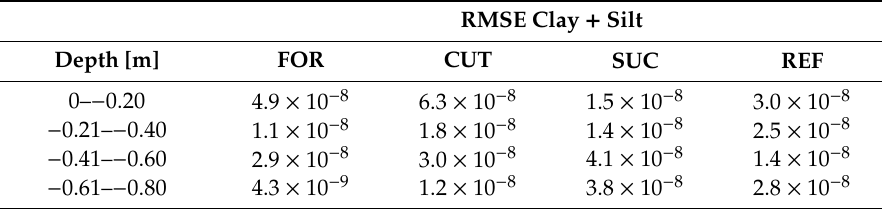
Table 8. Root mean square error (RMSE) interpolated raster clay + silt.